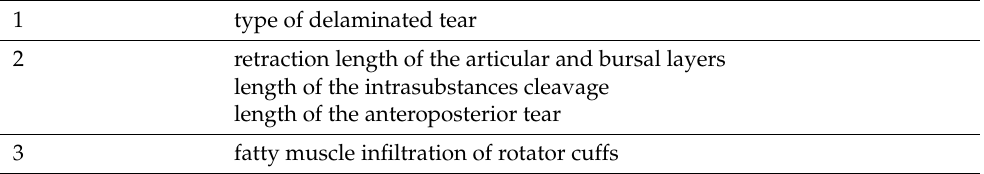
Table 3. Preoperative morphological MRI findings for delaminated tears of the rotator cuff.